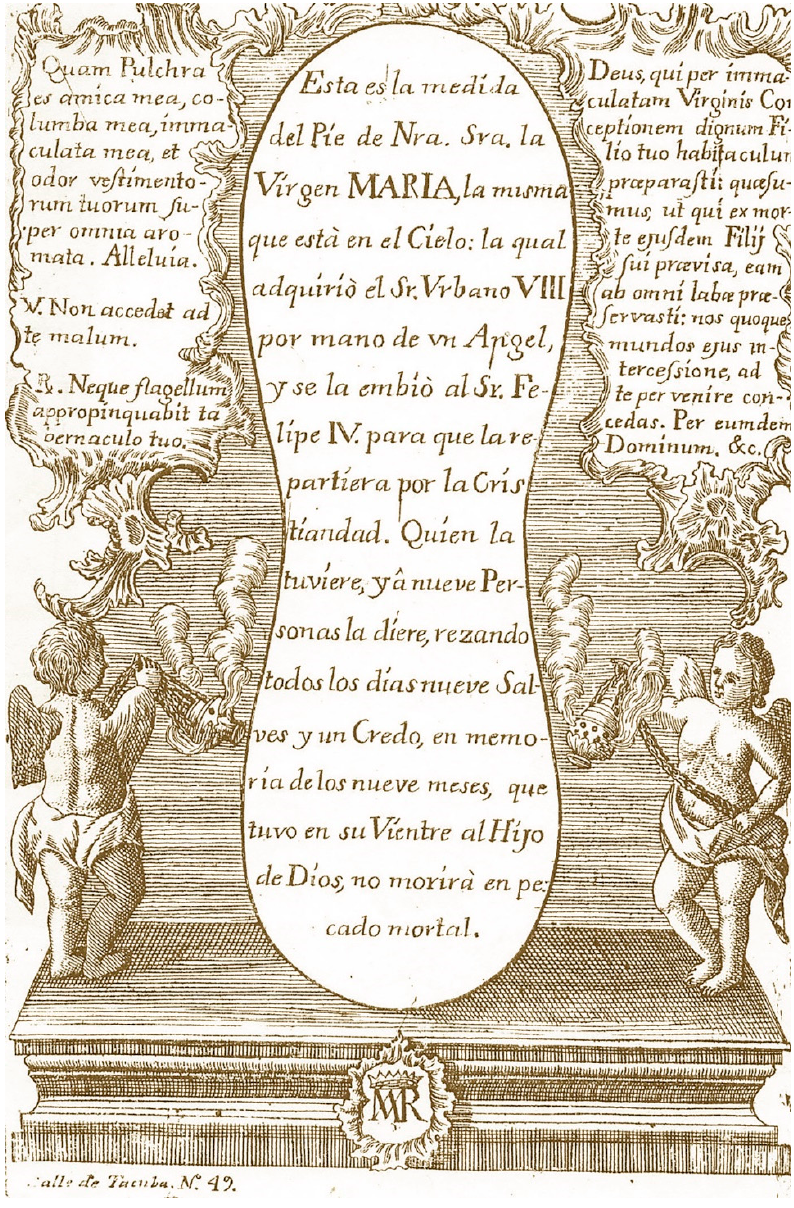
Figure 8. Anonymous, Medida del pie de Nuestra Señora , ca. 1780. Engraving. Photograph by the